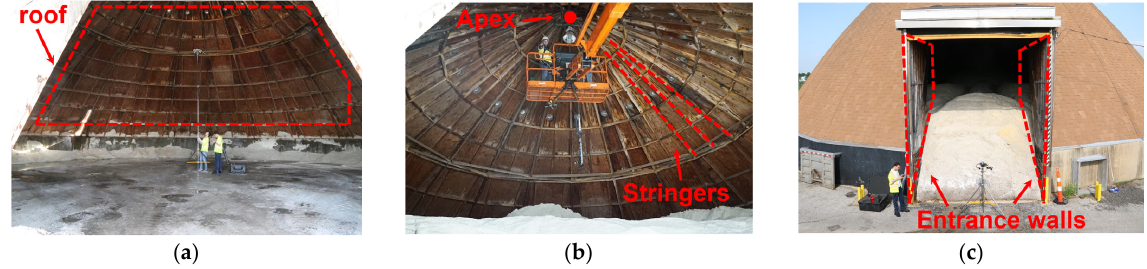
Figure 7. Demonstration of physical features constituting the dome storage facilities: ( a ) roof, ( b ) roof stringers, and ( c ) entrance walls (the SMART system is tripod-mounted at the center, roof-mounted at the center, and tripod-mounted at the entrance in these three examples, respectively).